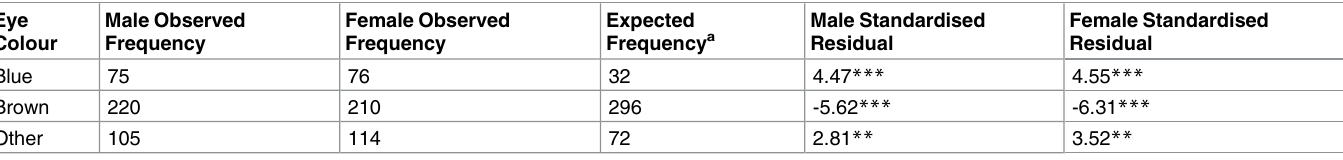
Table 2. Observed and expected eye colour frequencies in Brazil registeredcommercialmodels plus standardised residuals of a chi-square analy- sis for each